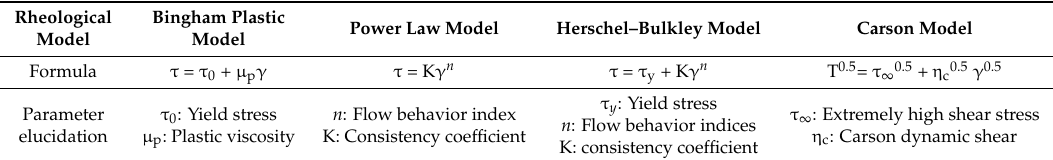
Table 1. Common rheological models of drilling